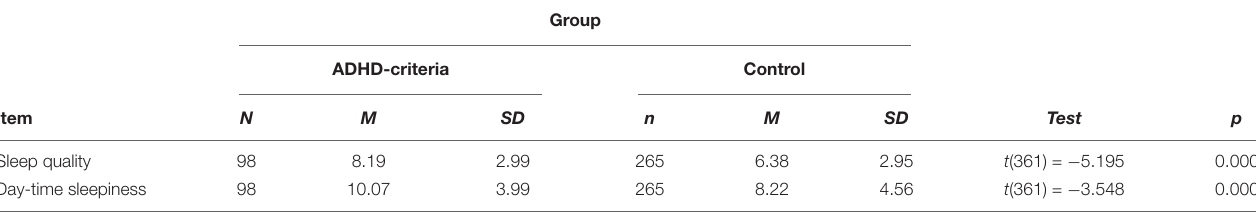
TABLE 1 | Sleep and ADHD criteria.